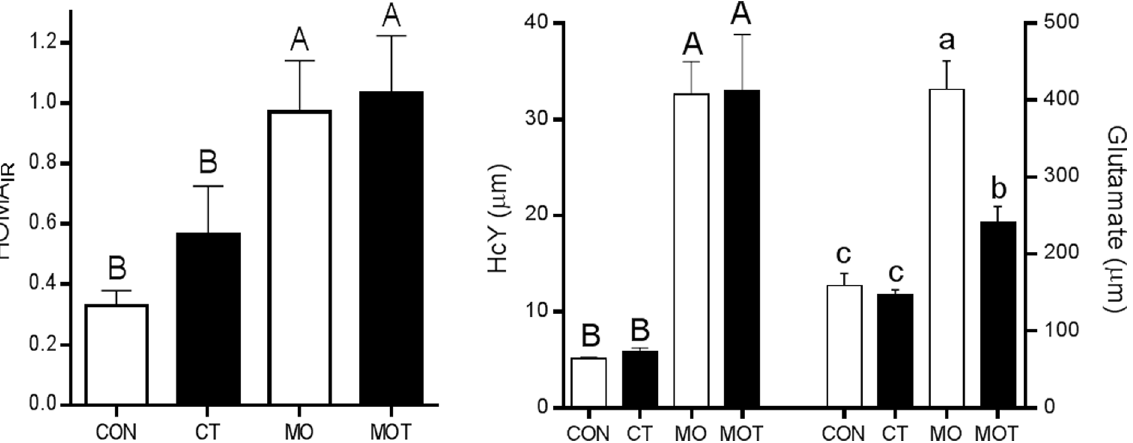
Figure 2. (a) Maternal HOMA IR values. Data are means 6 SEM, n=7–9 per group. (b) Maternal plasma homocysteine (HcY) and glutamate concentrations. Data are means SEM, n=7–9 per group. Upper case letter ( A , B ) superscripts indicate comparison procedures were conducted between all groups fed MO diet and all groups fed CON diet. Lower case letter superscripts ( a,b,c ) indicate multiple comparison procedures were conducted for diet and taurine interaction. Groups that do not share the same letter are significantly different from each other (p ,